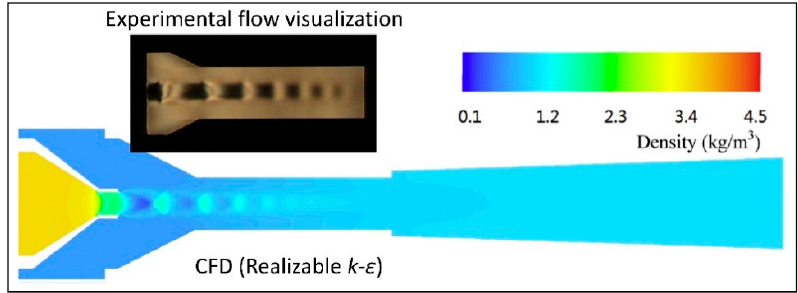
Figure 25. Comparison of CFD with Schlieren flow visualization [229].